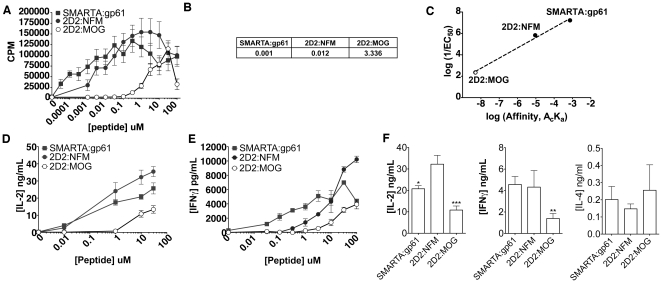
2D2 splenocytes stimulated with MOG have a low functional avidity.(A) 6×105 splenocytes from SMARTA or 2D2 mice were stimulated with various doses of the indicated antigen for 72 hrs. and 3H-Thy was added during the last 18 hrs. to assess proliferation. (B) The concentration of peptide needed to reach the half-maximal response (EC50 values, µM) were derived from the above proliferation assay using GraphPad Prism. (C) The reciprocal EC50 was plotted against the effective 2D affinity. The open circle for 2D2:MOG denotes the uncertainty of 2D2:MOG affinity, as it was below 10−8 µm4, the limit of detection for this assay. (D) 1.5×106 splenocytes were stimulated for 24 hrs. and supernatants were harvested to determine the amount of IL-2 by ELISA. (E) 1.5×106 splenocytes were stimulated for 24 hrs. and supernatants were harvested to determine the amount of IFN- γ by ELISA. (F) 1.5×106 splenocytes were stimulated with 10 µM of the indicated antigen and supernatants were harvested (24 hrs. for IL-2 and IFN-γ or 48 hrs. for IL-4) to determine the amount of cytokine by ELISA (P value: * = 0.025, ** = 0.005, ***<0.002). All experiments were performed at least three times.